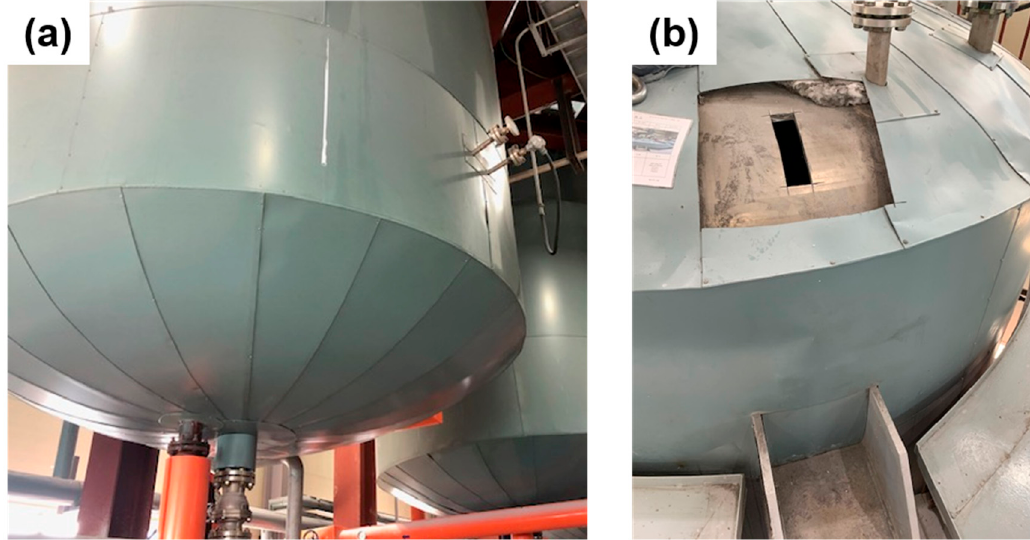
Figure 1. ( a ) Photographs of polyvinyl chloride (PVC) stabilizer reactors. ( b ) Top part of the reactor was the cutoff. Even though it is not shown in this image, the bottom part of the reactor cutoff was the same way as the failure analysis.